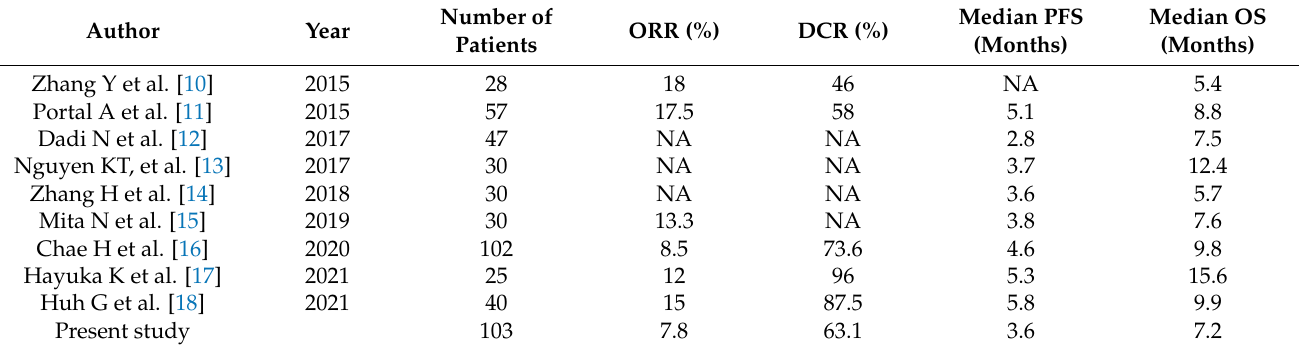
Table 7. Previous studies on second-line gemcitabine plus